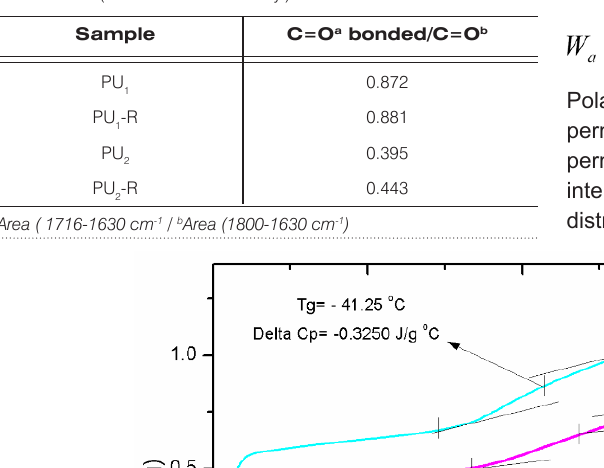
and PU and the PU 1 2